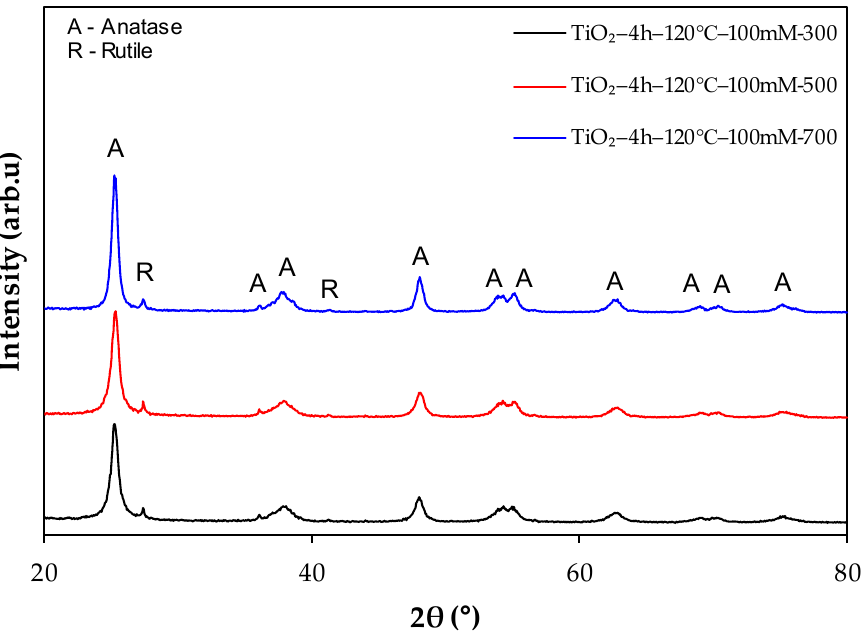
Figure 2. XRD patterns of APTES-modified TiO 2 . Table 1. XRD phase composition and average crystallite size of APTES-modified TiO 2 as well as reference samples.